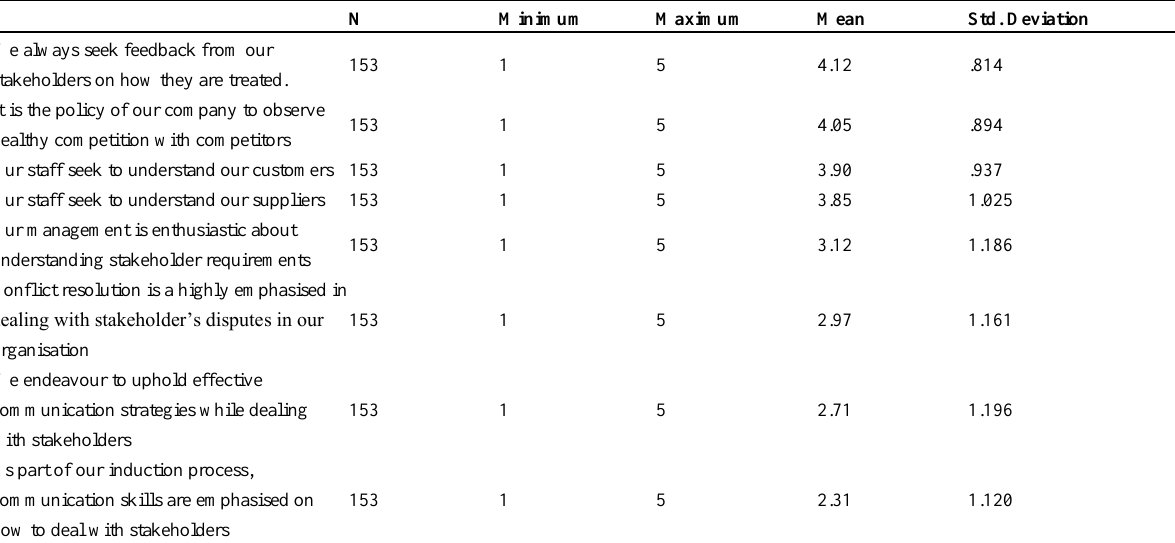
Table 1: Descriptive Statistics for Relationship